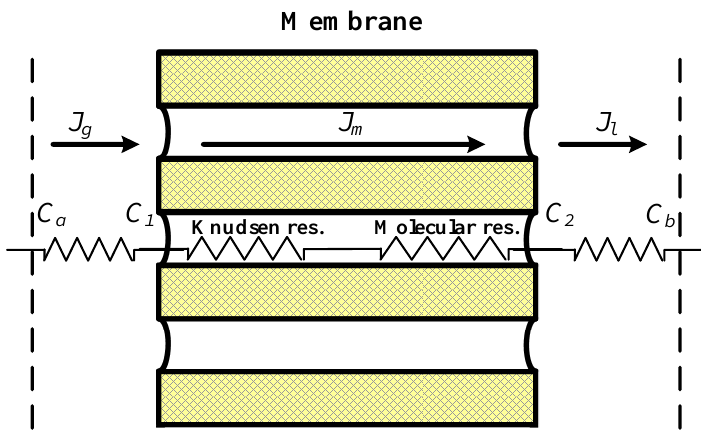
Figure 1. Schematic diagram of mass transfer resistances in a gas – liquid membrane contactor.